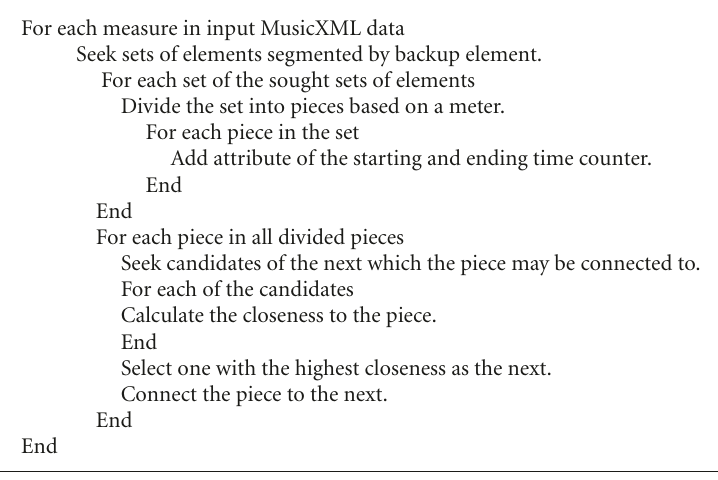
Algorithm 1: Parallel voice division.